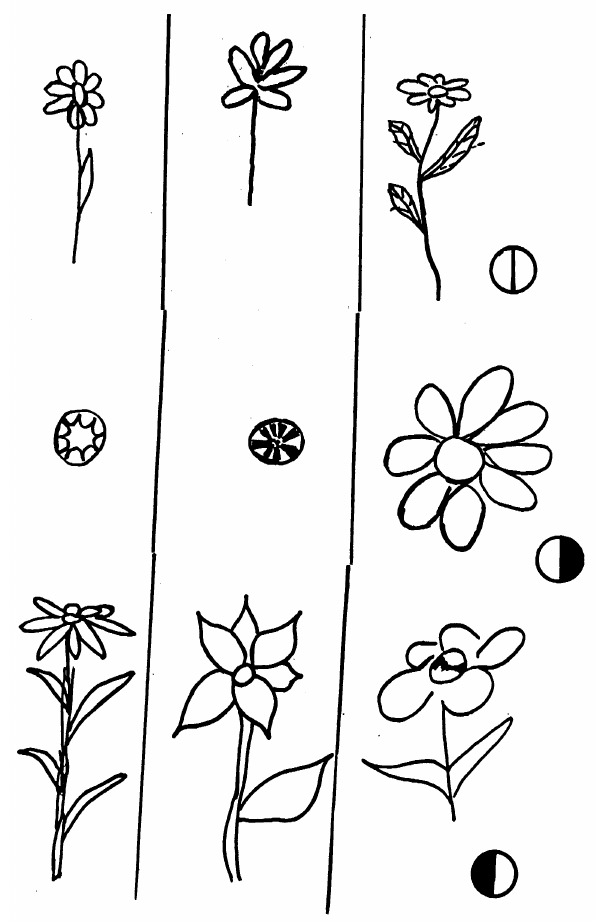
FIG 6. Drawings of a flower by three patients. The sup pressed hemisphere is shaded.